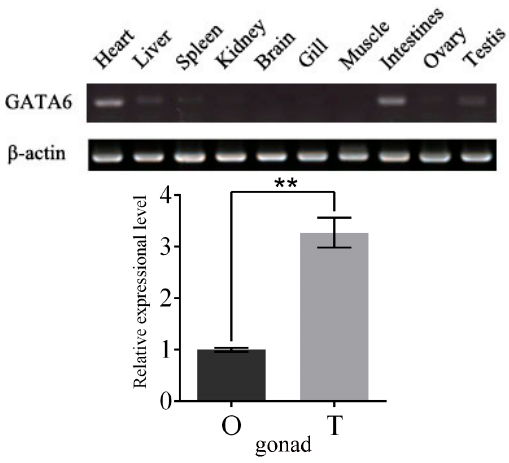
Figure 7. ( A ) Analysis of GATA6 transcripts for various tissues in P. olivaceus . Semi-quantitative RT-PCR analysis was used to quantify GATA6 mRNA with β -actin as a reference; and ( B ) analysis of GATA6 transcripts in the gonads of P. olivaceus . qRT-PCR analysis was used to quantify GATA6 mRNA with β -actin as a reference. The relative expression variance is presented as a ratio (amount of GATA6 mRNA normalized to the values of the corresponding reference genes). The data are shown as the mean ± SD ( n = 3). The asterisks show a significant difference ( p < 0.01).